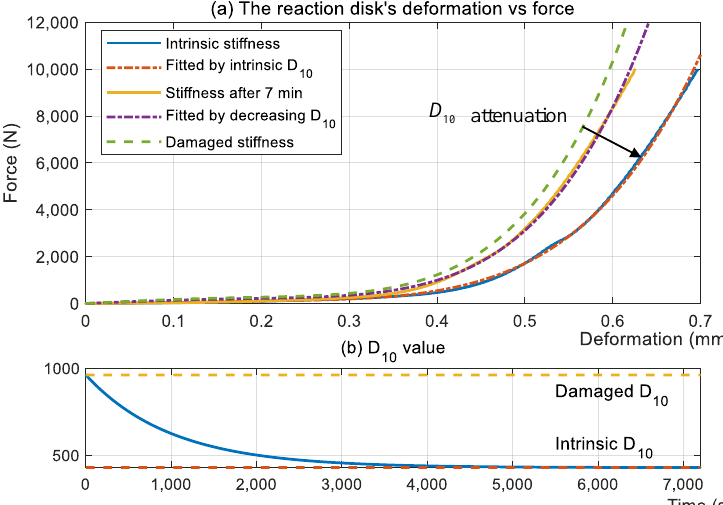
Figure 4. The quasi-static behavior of the reaction